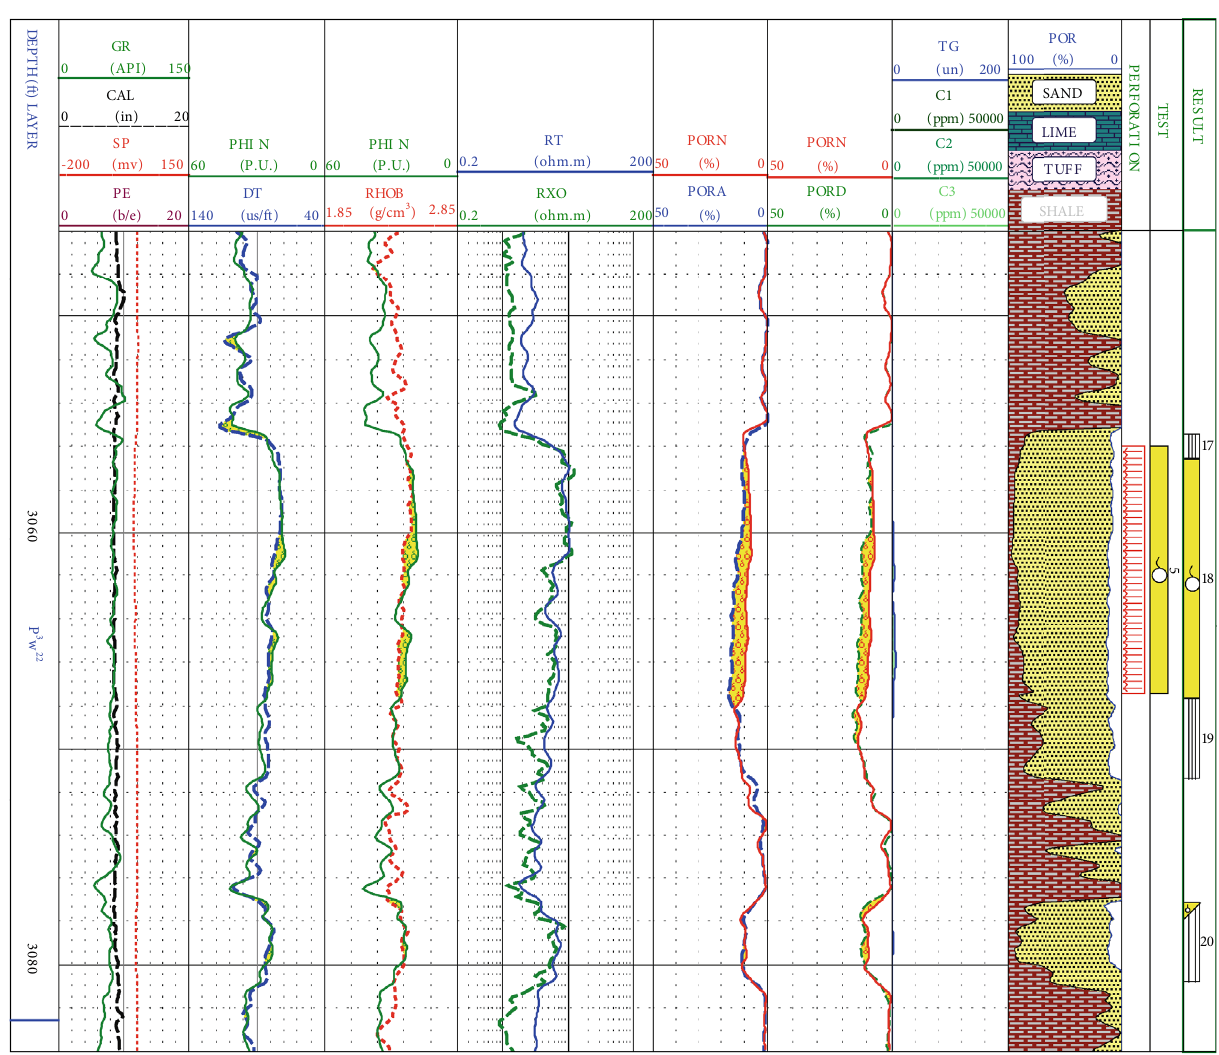
W reservoir. 3 2